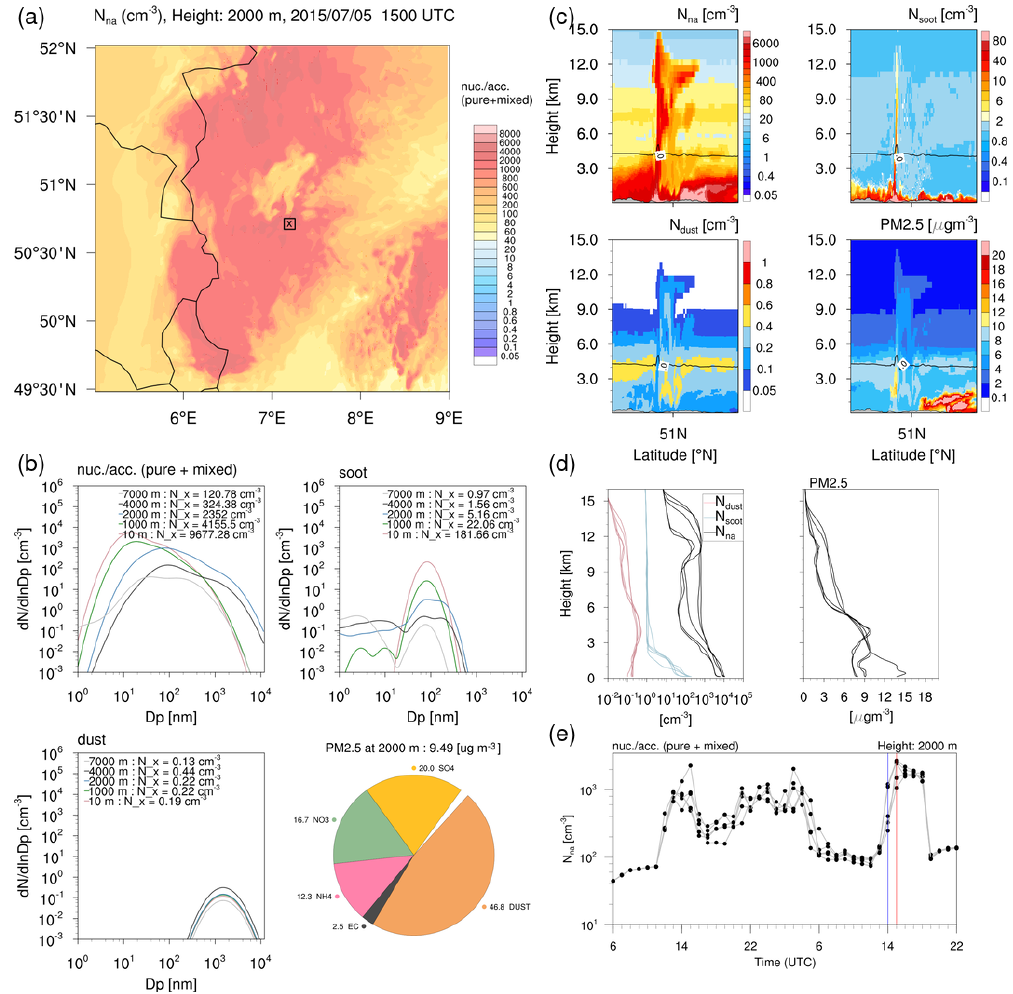
Figure 5. Same as Fig. 4 but on 5 July 2015 at